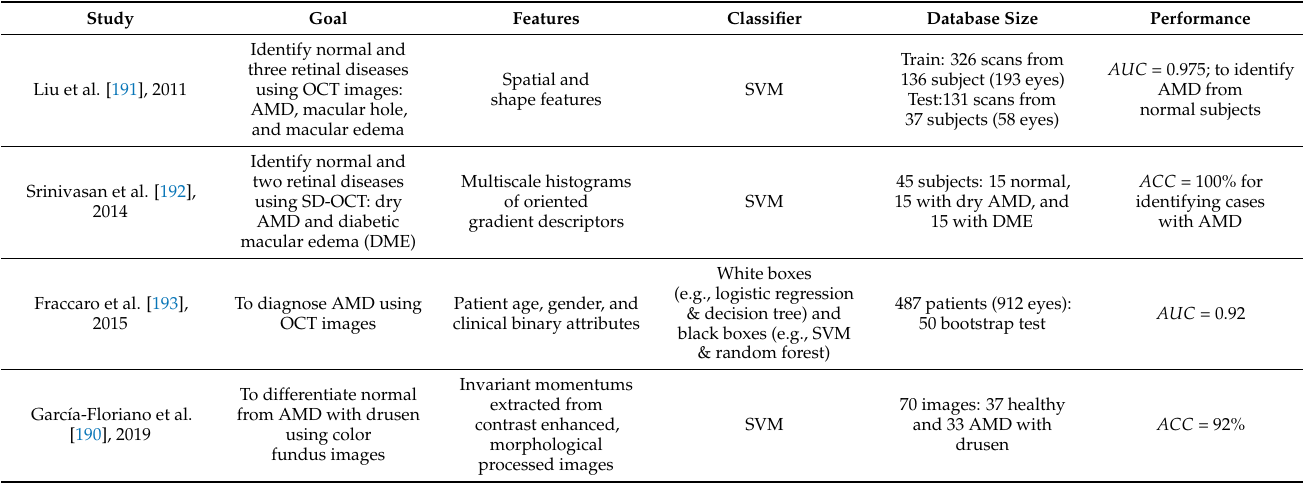
Table 3. Traditional ML methods for early detection, diagnosis, and grading of